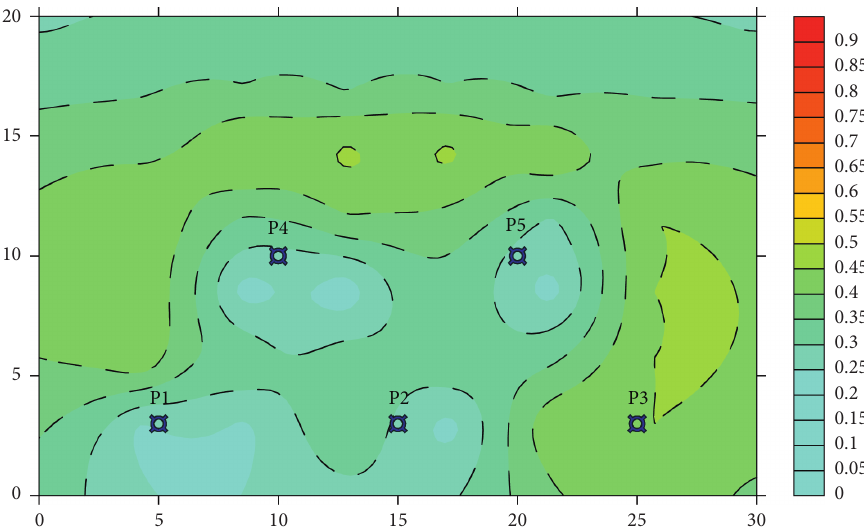
Figure 7: Remaining oil saturation distribution of binary flooding with strong edge water.